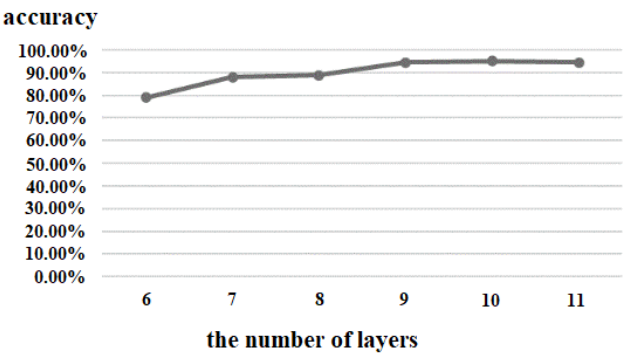
Figure 9. Comparison of different number of layers of 3D CNN.